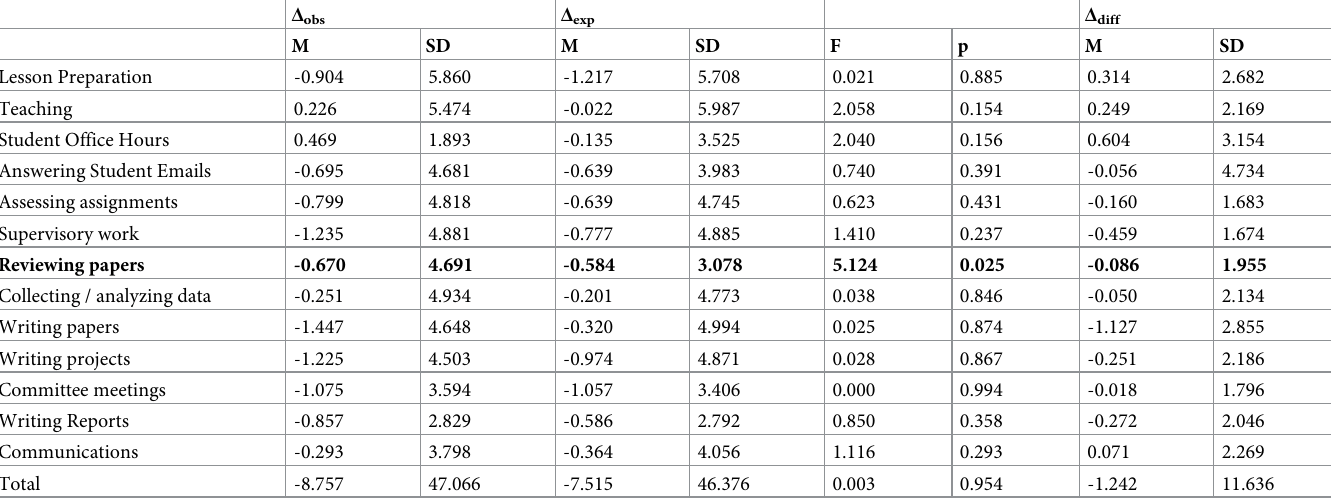
Table 5. Comparison of observed and expected changes in working hours, the first and second pandemic